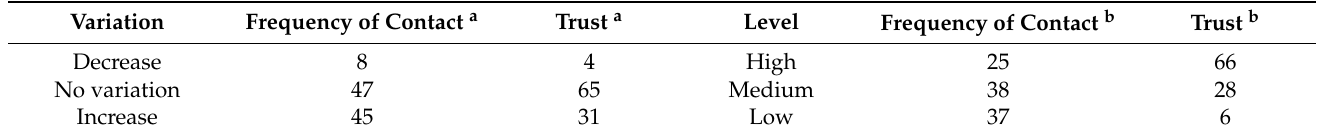
Table 5. Frequency of contact and trust level between key stakeholders (in percentages). Own elabo- ration based on the analysis of the structured questionnaire (2nd phase). ( a ): Existing relationships prior to the SI process; ( b ): total relationships during the SI